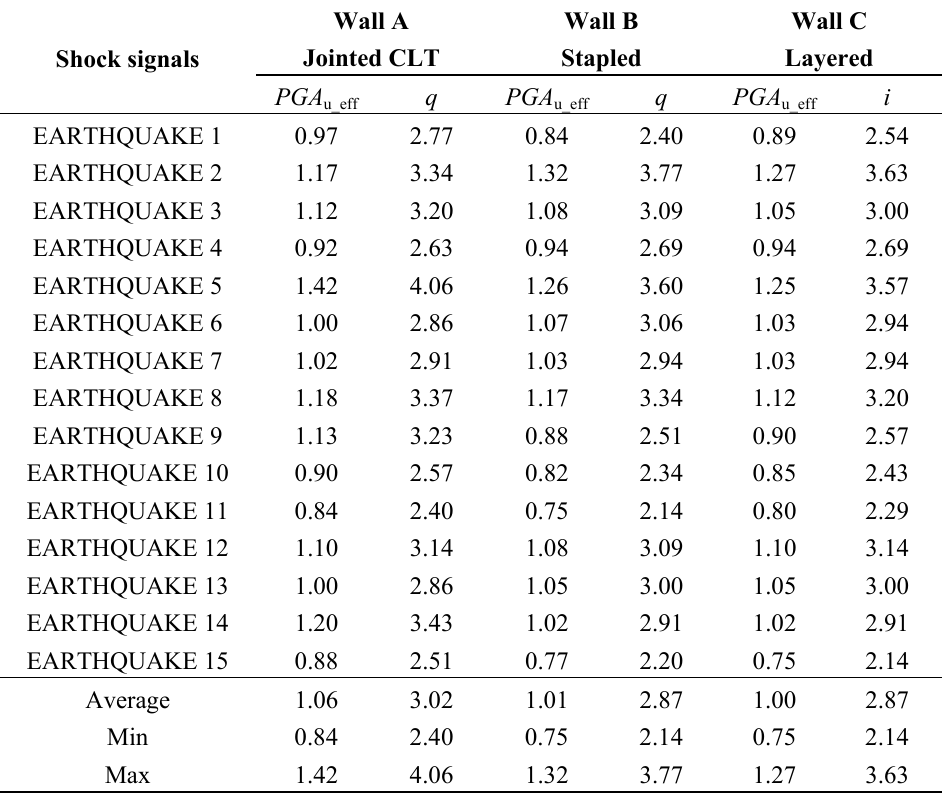
Table 5. PGA values and q -factor values for numerically analysed u_eff